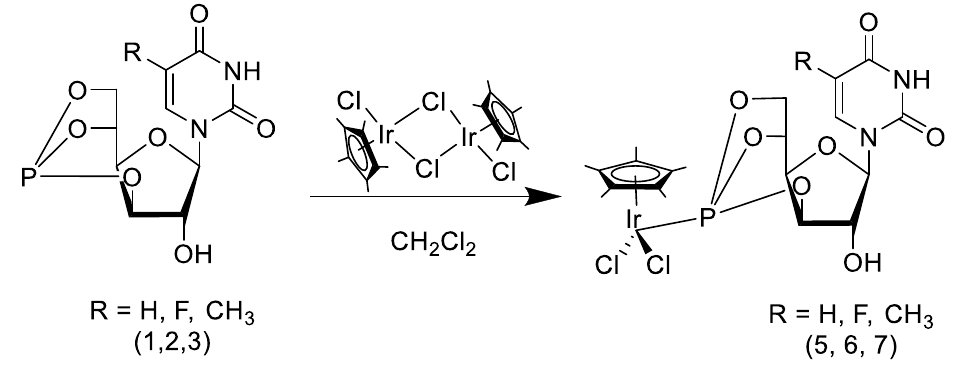
Figure 1. Cyclophosphamide (left), ifosfamide (midde), thiotepa (right).